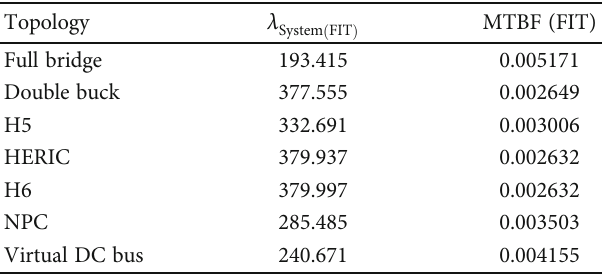
Table 12: Total reliability of inverters.